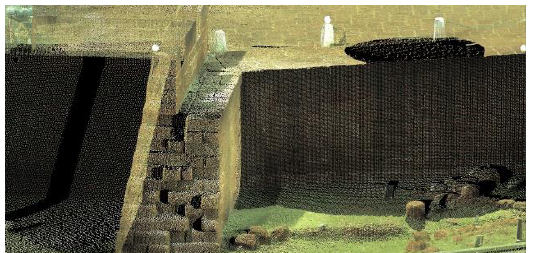
Figure 6. The details of the point cloud data of the front part of the monument